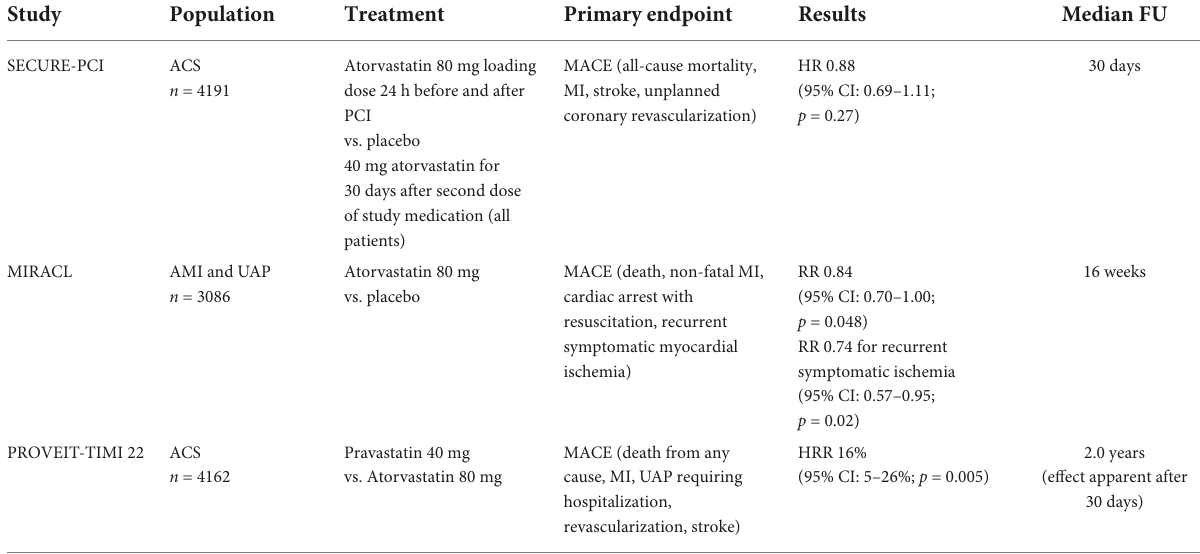
TABLE 1 Trials with early initiation of low density lipoprotein-cholesterol (LDL-C) lowering therapy post-acute coronary syndrome (ACS).